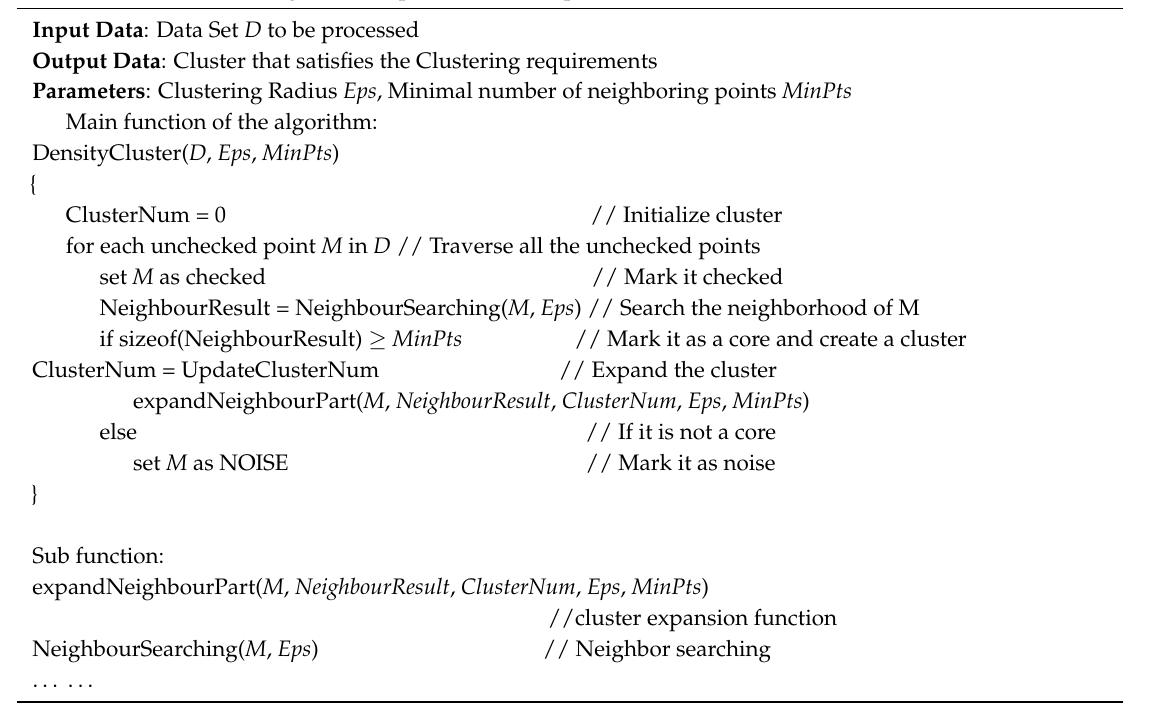
Algorithm 1. DBSCAN algorithm implementation steps.